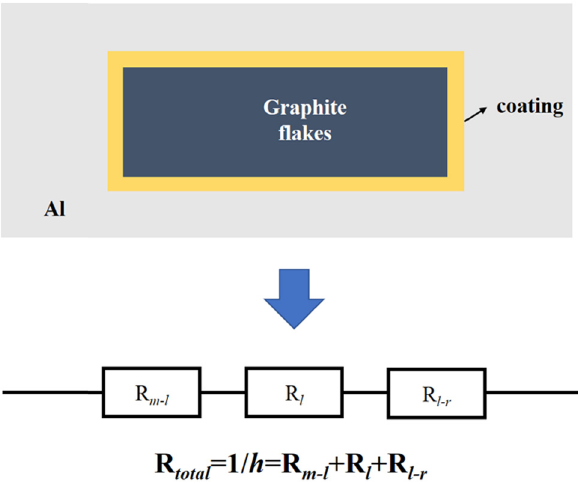
Figure 1: Schematic diagram of the interfacial thermal resistance of graphite fl akes/Al composites with an interfacial